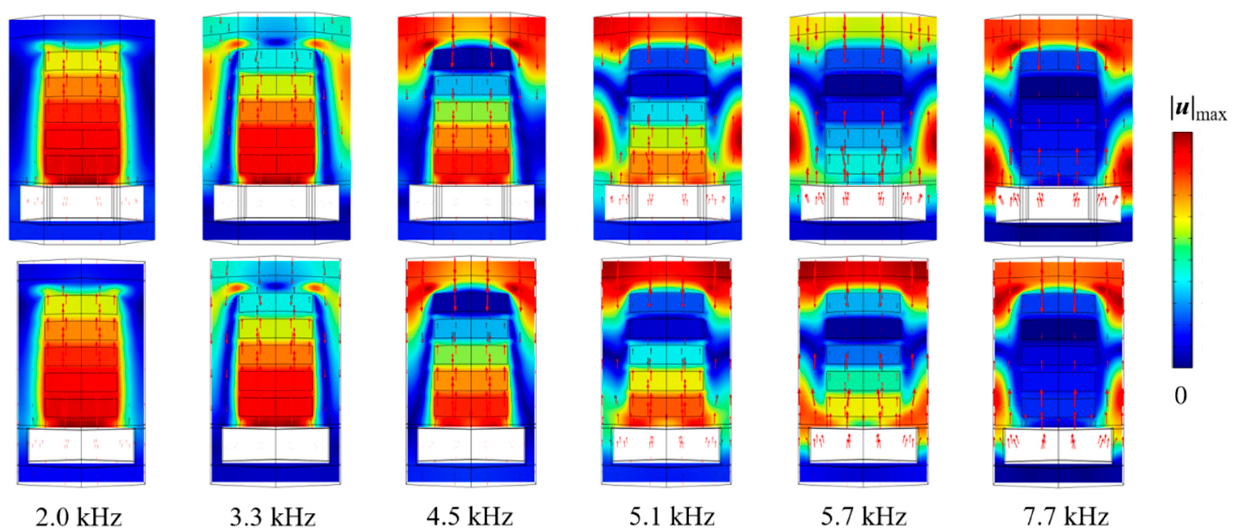
Figure 6. Forward absorbing displacement field and particle velocity vector (the first and second rows indicate the x – z and y – z cross-sections, respectively).